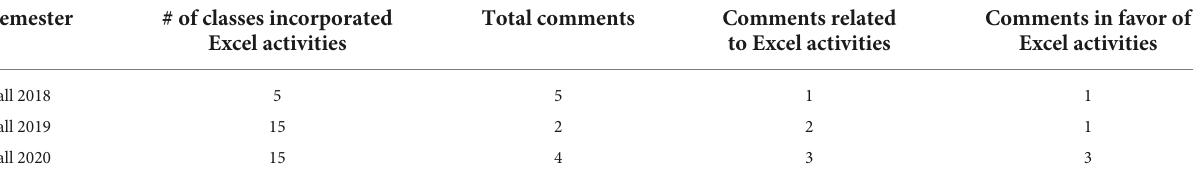
TABLE 2 Summary of Students’ comments for CE